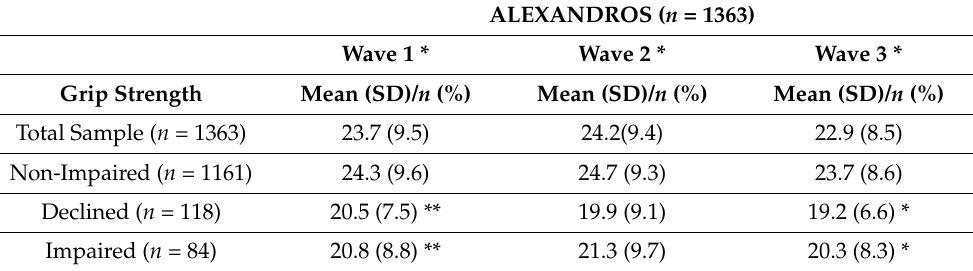
Table 3. Distribution of the physical functioning outcomes across different wave in the ALEXAN- DROS